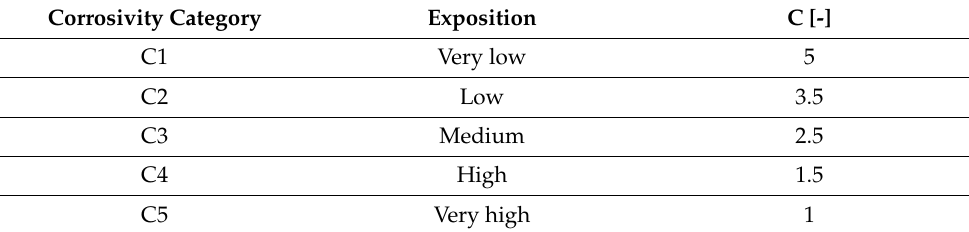
Table 1. Suggested values of C for each corrosivity category according to